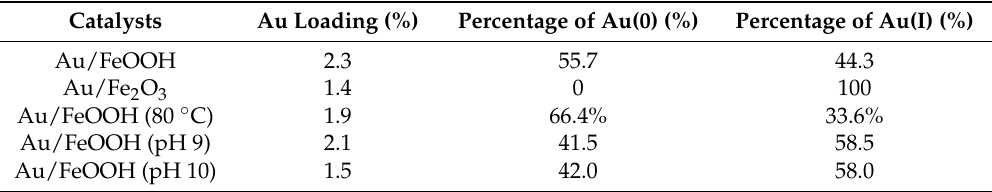
Table 2. Actual loading and oxidation state of gold on various catalysts.